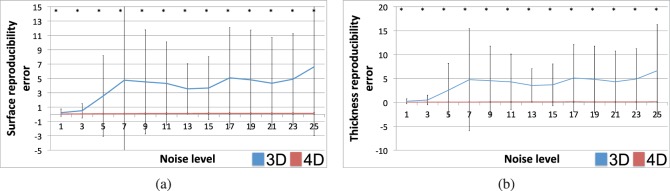
Choroid segmentation reproducibility in the presence of simulated speckle noise. (a) Lower-choroid surface position reproducibility error (μm) per noise level (σ of Gaussian kernel). Longitudinal (4D, red) segmentation resulted in significantly more reproducible surfaces (P < 0.001) than cross-sectional (3D, blue) segmentation for each tested noise level. (b) Choroid thickness reproducibility error (μm) per noise level. Four-dimensional segmentation led to significantly more reproducible thickness measurements (P < 0.001) than 3D segmentation for each tested noise level. Note that the error bars for the 4D plots are difficult to see because of their small scale.